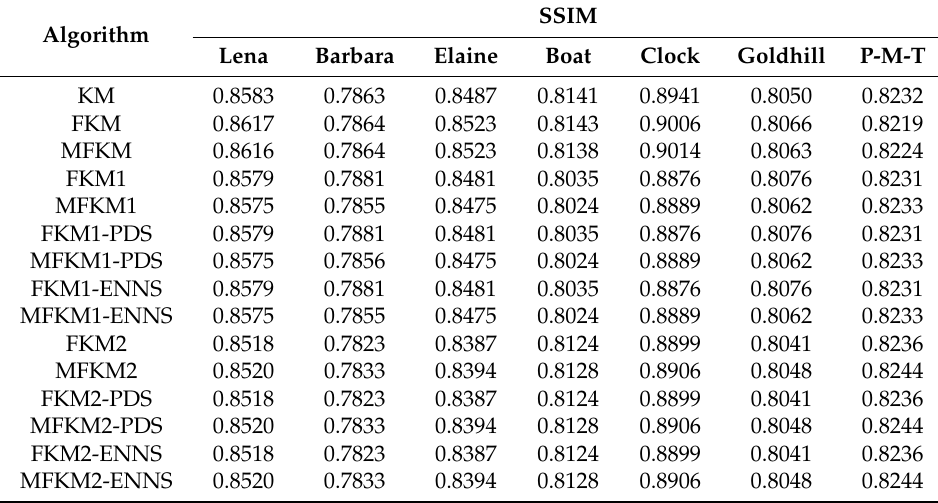
Table 12. SSIM for images Lena, Barbara Elaine, Boat, Clock, Goldhill and P-M-T, using N = 128.